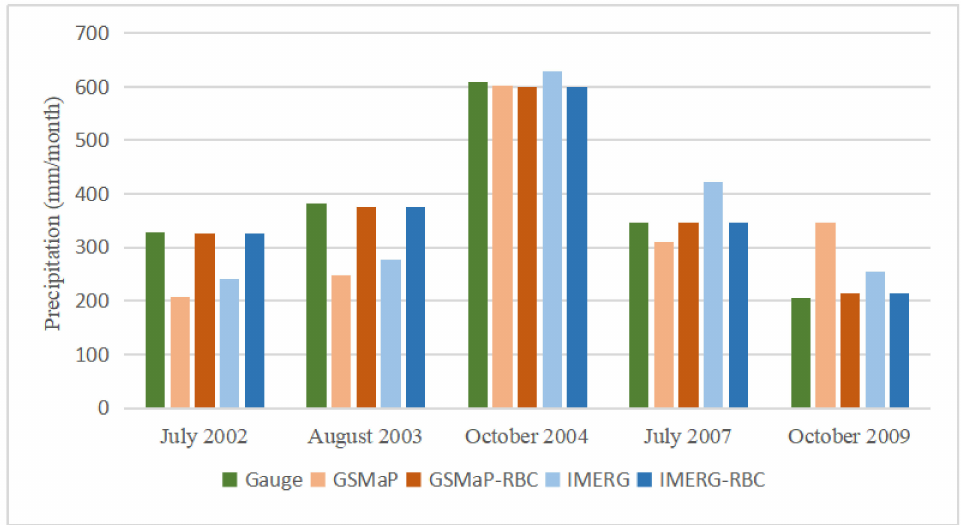
Figure 4. Inter-comparison of cumulative rainfall of different precipitation datasets in five selected months during